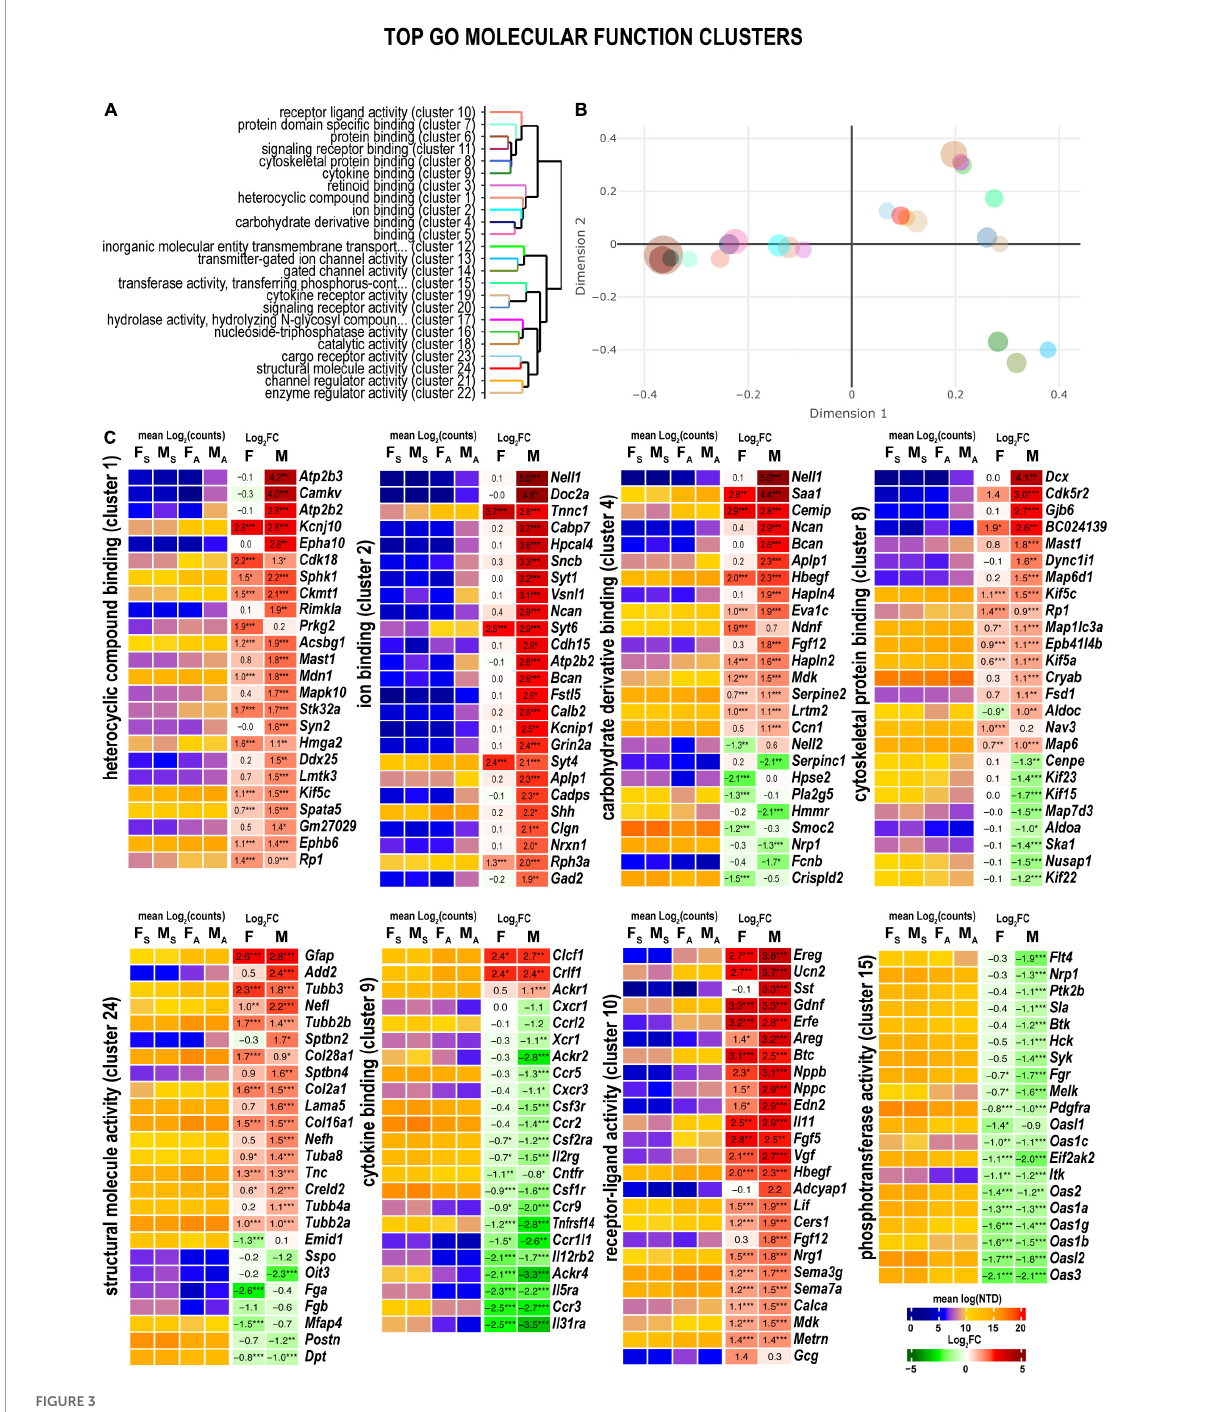
FIGURE3 Axotomy influenced distinct molecular functions in each sex. (A) Clustering of significant gene ontology (GO) molecular functions based on best-match average (BMA) distances. (B) Wang distances of GO molecular function clusters projected on a two-dimensional scaling plot using the ViSEAGO R package. (C) Heatmaps of differentially expressed genes (DEGs) associated with eight GO molecular functions: heterocyclic compound binding (cluster 1), ion binding (cluster 2), carbohydrate derivative binding (cluster 4), cytoskeletal protein binding (cluster 8), cytokine binding (cluster 9), receptor-ligand activity (cluster 10), phosphotransferase activity (cluster 15), and structural molecule activity (cluster 24). Heatmaps display normalized mean log 2 (counts) in sample groups (F S , female sham; M S , male sham; F A , female axotomy; M A , male axotomy) and log 2 FC in female (F) and male (M); ( n = 6 mice/group, 2 mice/sample (pooled), 3 sample/group) of respective DEGs. Log 2 FC significance was determined in DESeq2 using Wald test: *, p ≤ 0.05; **, p ≤ 0.005; ***, p ≤ 0.0005. DEGs were sorted by log 2